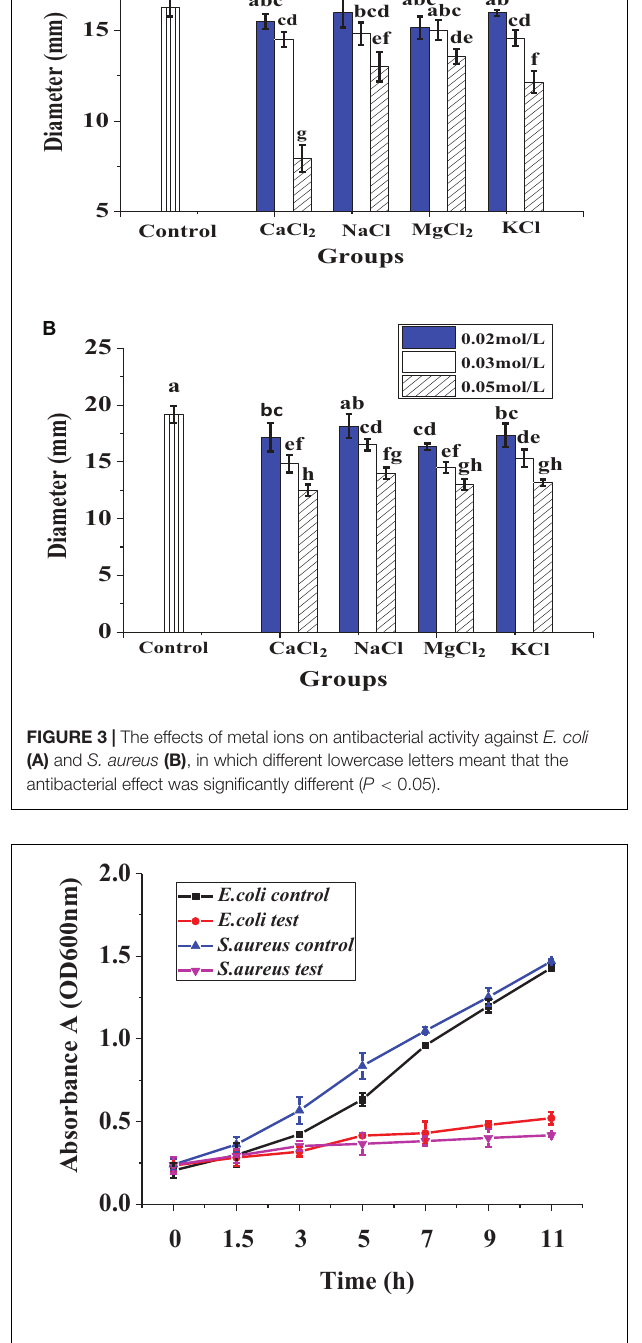
FIGURE 4 | The dynamic growth curve of the two indicator bacteria.